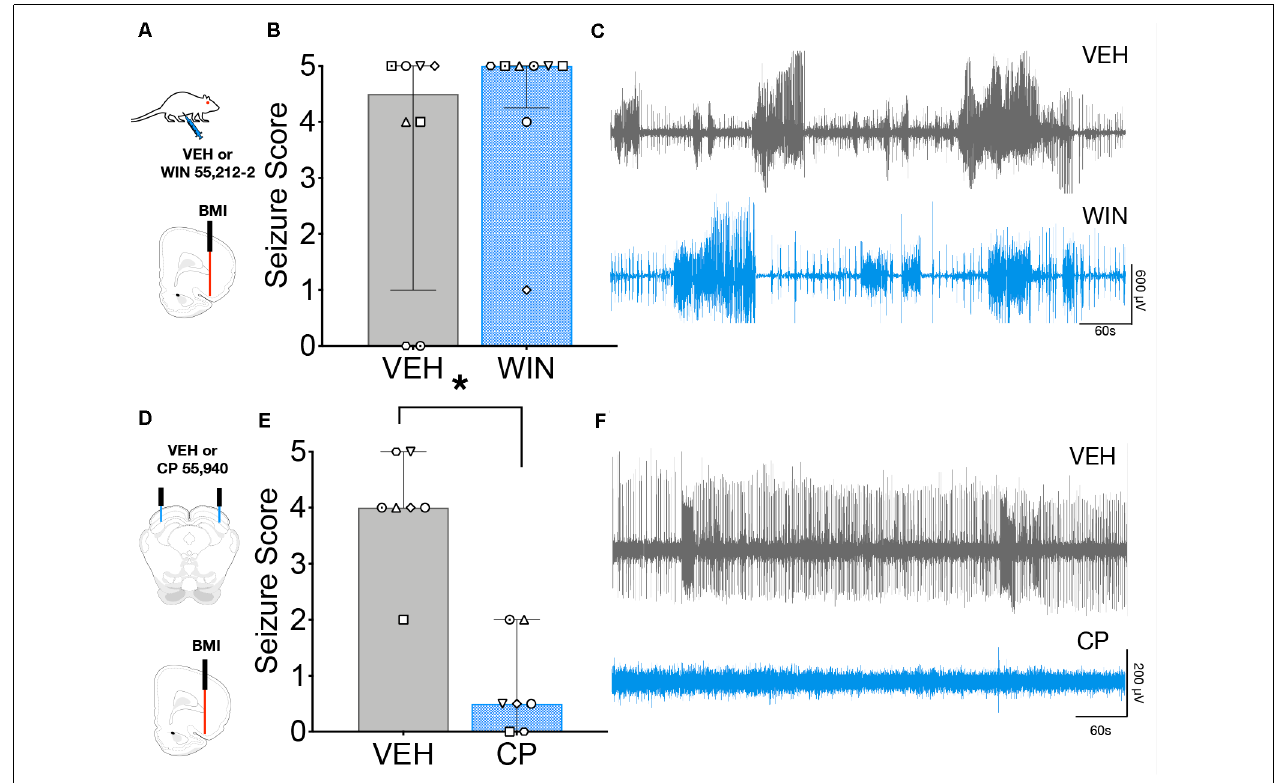
FIGURE 4 | Intracollicular, but not systemic cannabinoid (CB) receptor activation suppresses seizures evoked from Area Tempestas (AT). (A) Seizures were evoked by injection of the GABA-A receptor antagonist, bicuculline methiodide (BMI) into the AT after systemic administration of VEH or WIN 55,212-2. (B) Behavioral seizure severity under the vehicle (VEH) and WIN treated conditions did not differ. (C) Representative electrographic seizures from the same subject under VEH and WIN treated conditions, showing multiple high amplitude events and isolated interictal spiking. (D) Seizures were evoked by injection of BMI into the AT following either VEH or CP infusion into the DLSC. (E) Seizure severity was significantly reduced by CP infusion into the DLSC. (F) Representative electrographic activity following treatment of the DLSC with VEH (top) and CP (bottom) from the same subject, showing that behavioral seizure suppression co-occurred with suppression of electrographic seizure activity. Bars show median and interquartile range, symbols show individual subjects. * p <